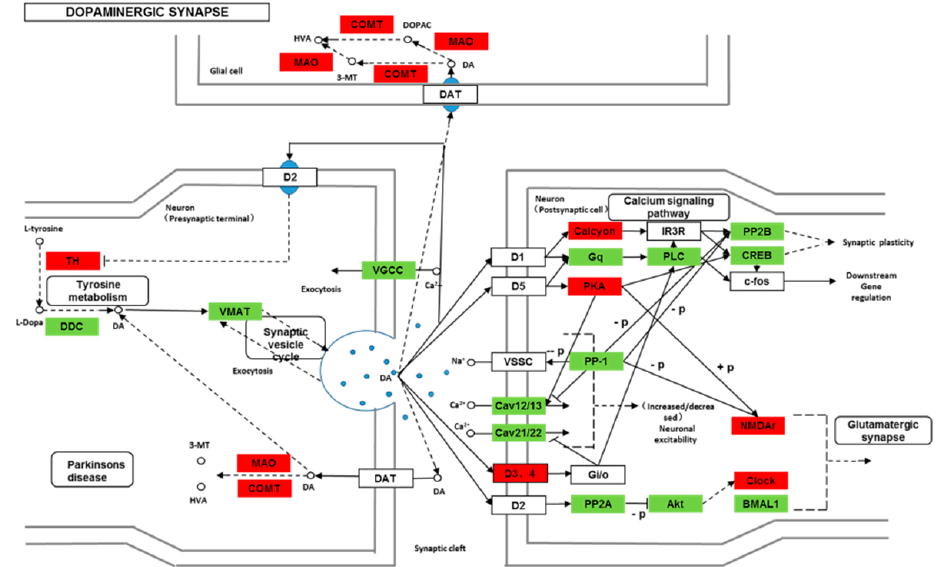
Figure 9. Differentially expressed genes in the dopaminergic synapse between mandarin fish in the control group (CG) and the learning group (LG) from a transcriptome analysis. The colors of rectangles were shaded according to the different expression (red: The mRNA expression levels of fish in Group LG were significantly higher than those in Group CG (FDR ≤ 0.001, the absolute value of log2 (Ratio) ≥ 1); green: The mRNA expression levels of fish in Group LG were significantly lower than those in Group CG (FDR ≤ 0.001, the absolute value of log2 (Ratio) ≥ 1)).